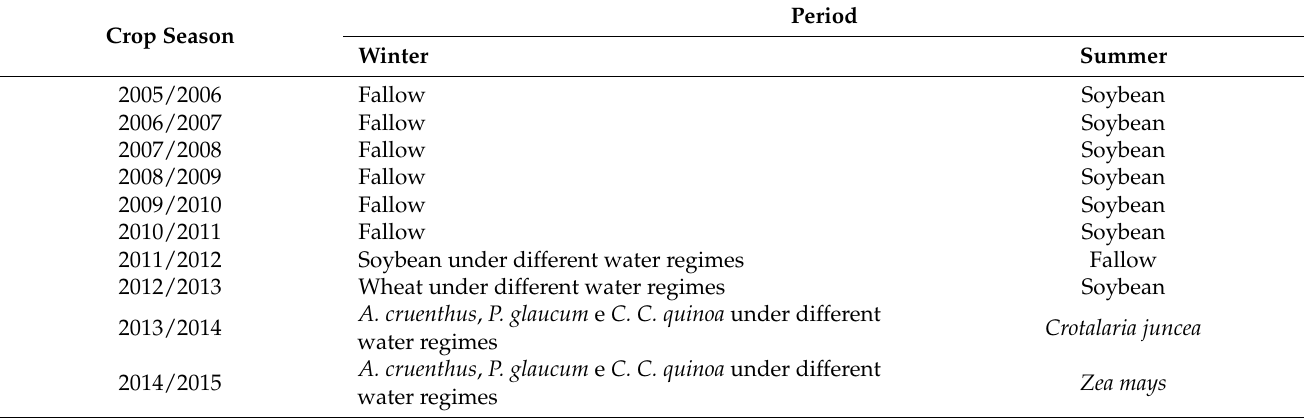
Table 1. Description of the cultivation history of the studied area between 2005 and 2015.